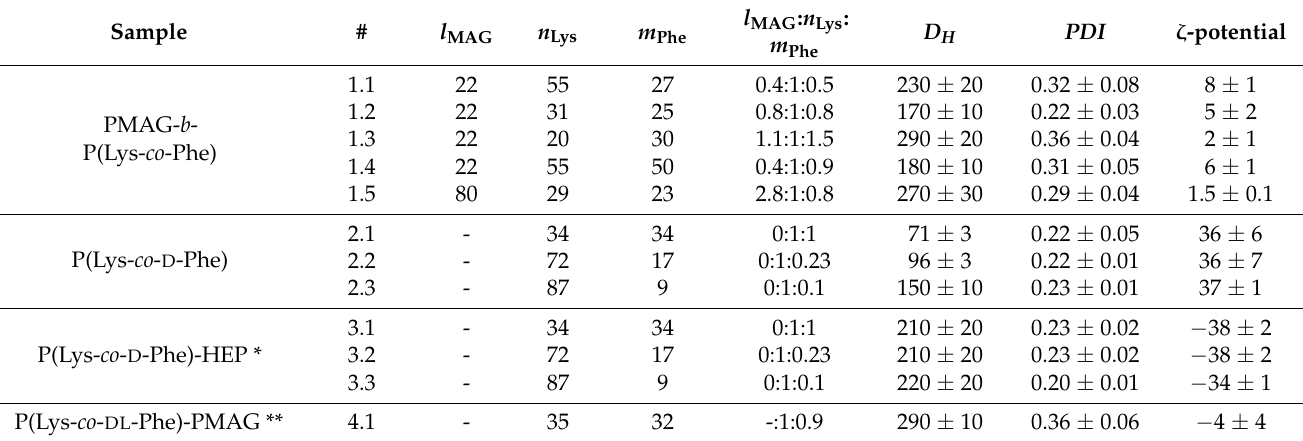
Table 2. Composition of P(Lys n - co -Phe m ) and PMAG l - b -P(Lys n - co -Phe m ) copolymers and characteris- tics of self-assembled nanoparticles in 0.01 M PBS, pH